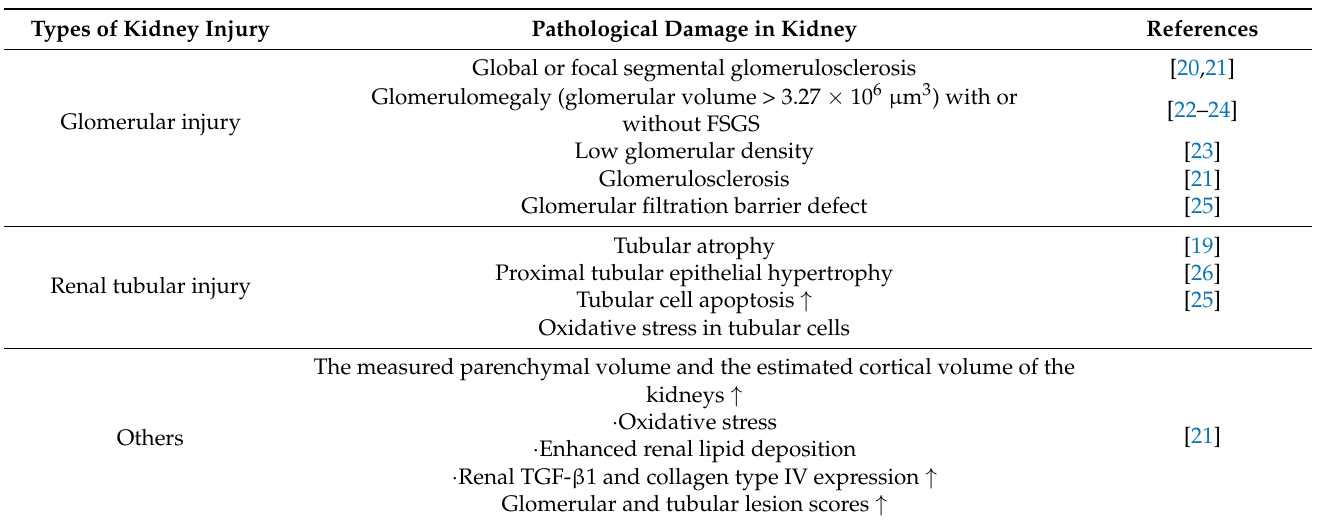
Table 1. Studies on obesity-related kidney